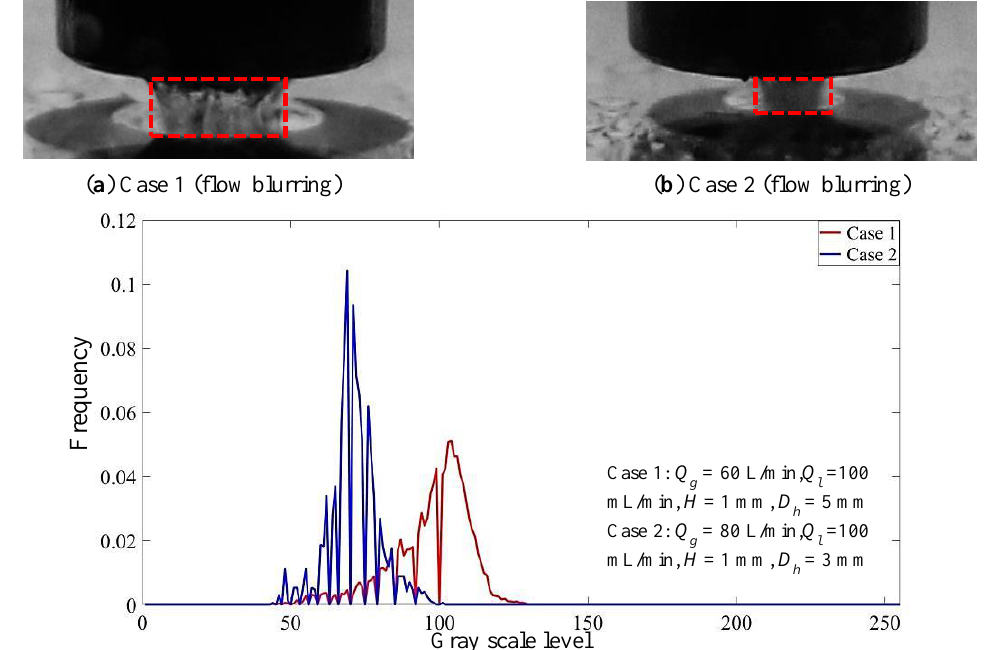
Figure 5. The experimental image with different mixing intensity and its gray distribution.